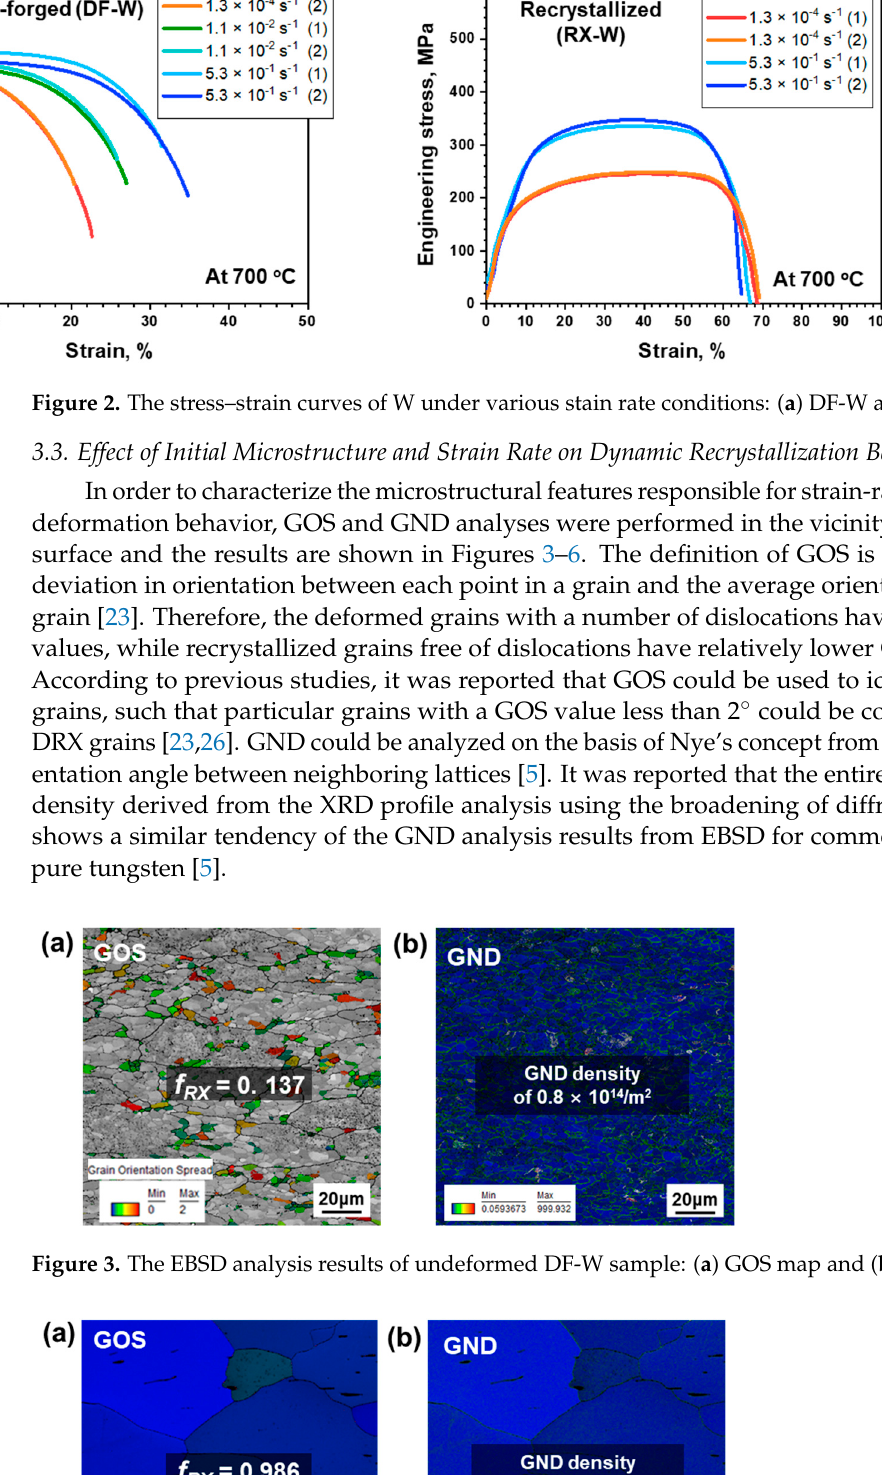
Figure 5. The GOS and GND maps of DF-W sample after tensile tests: ( a , d ) static (1.3 × 10 − 4 s − 1 ), ( b , e ) intermediate-strain-rate (1.1 × 10 − 2 s − 1 ), ( c , f ) high-strain-rate (5.3 × 10 − 1 s − 1 ) conditions.